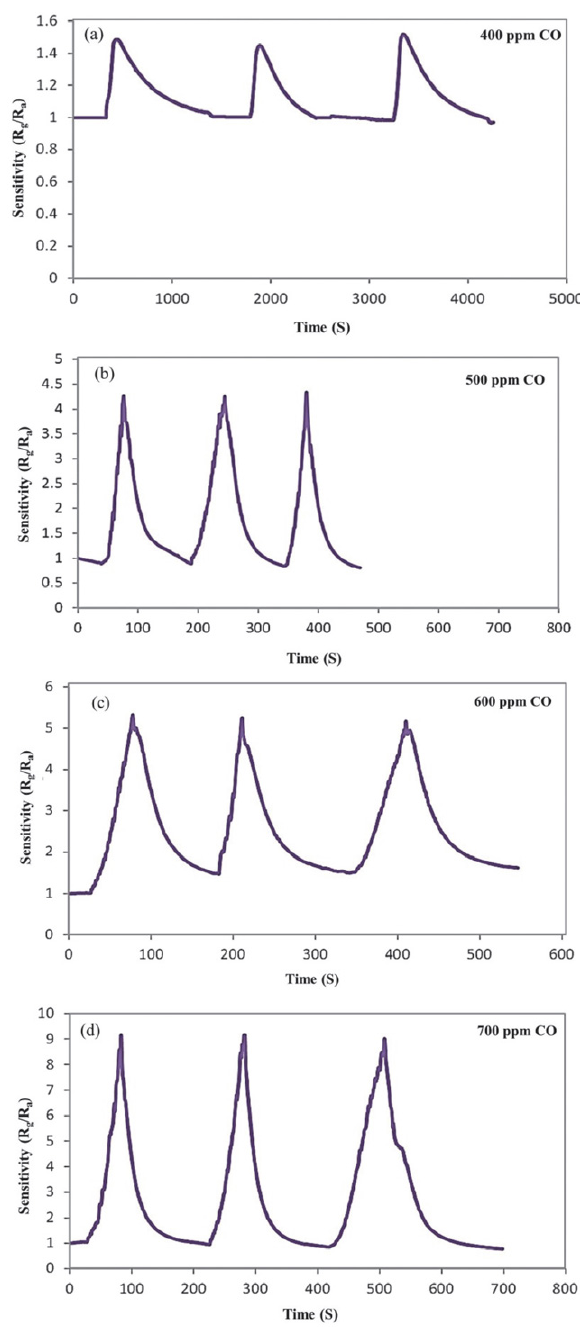
Figure 10 . Reproducibility of the calcinated CuO nanofibers sensor on successive exposure (3 cycles) to (a) 400 ppm (b) 500 ppm (c) 600 ppm (d) 700 ppm of CO at